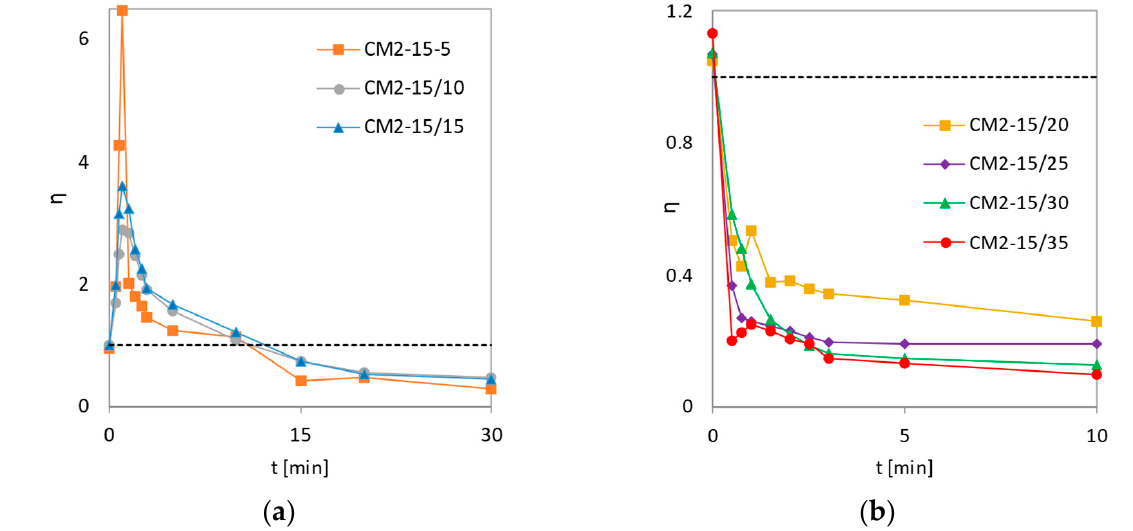
Figure 9. Dependence of the surface utilization factor on dissolution time for co-milled mixtures with 2 mm balls and SLS content of 15 wt.%. The co-milling time was: ( a ) 5, 10, and 15 min; ( b ) 20, 25, 30, and 35 min.